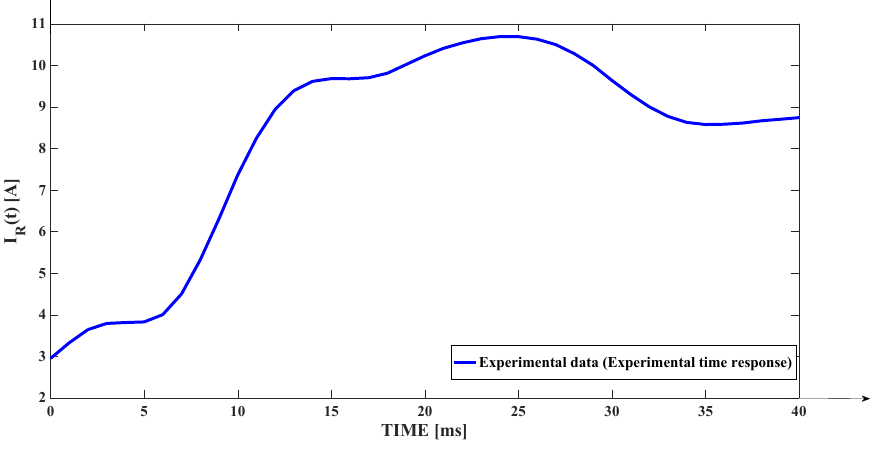
Figure 8. Dynamics of the I R (t) signal.